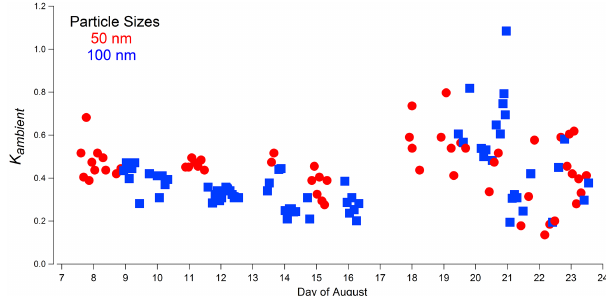
Figure 6. Time series (PDT) for 7–24 August of CCN-derived κ ambient of monodispersed ambient aerosol having dry mobility di- ameters of 50nm (red circles) and 100nm (blue squares). The rela- tive error in κ ambient is ±